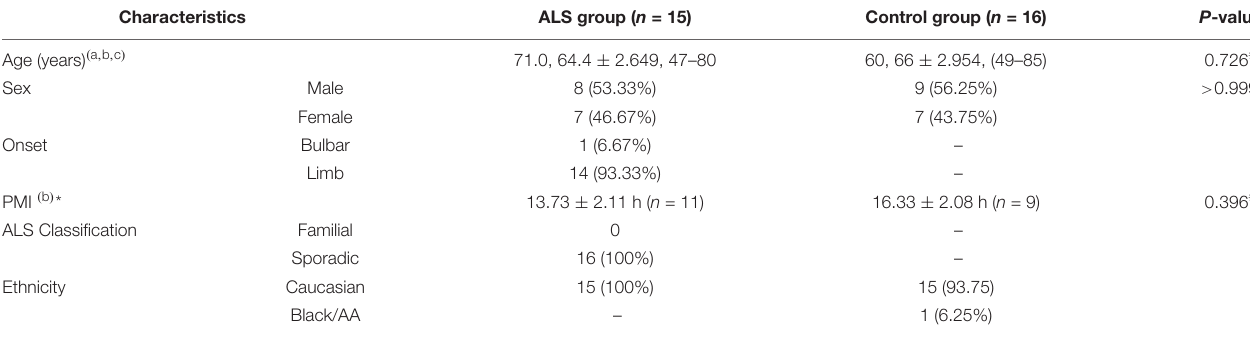
TABLE 1 | Clinical characteristics of study participants.